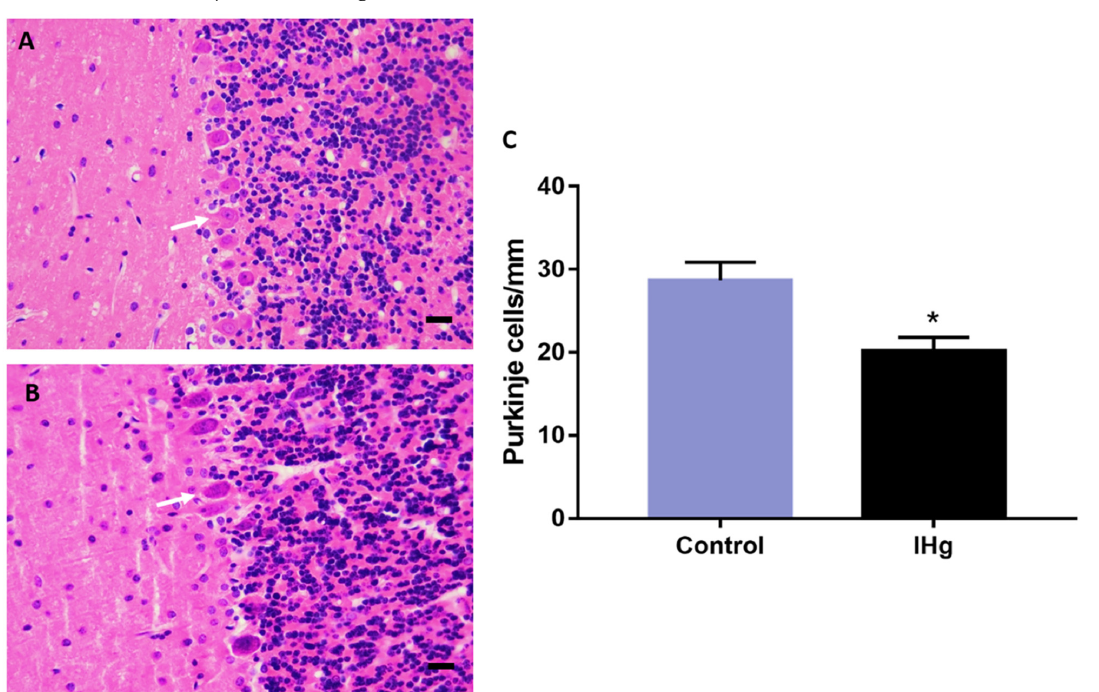
Figure 6. Morphological analysis of the cerebellum of rats exposed to 0.375 mg/kg of HgCl 2 for 45 days. In ( A , B ), repre- sentative photomicrographs of control and exposed groups, respectively. In ( C ), results are expressed as mean ± S.E.M and * p < 0.05, t -Student test (n = 12). Scale bar: 20 µm.